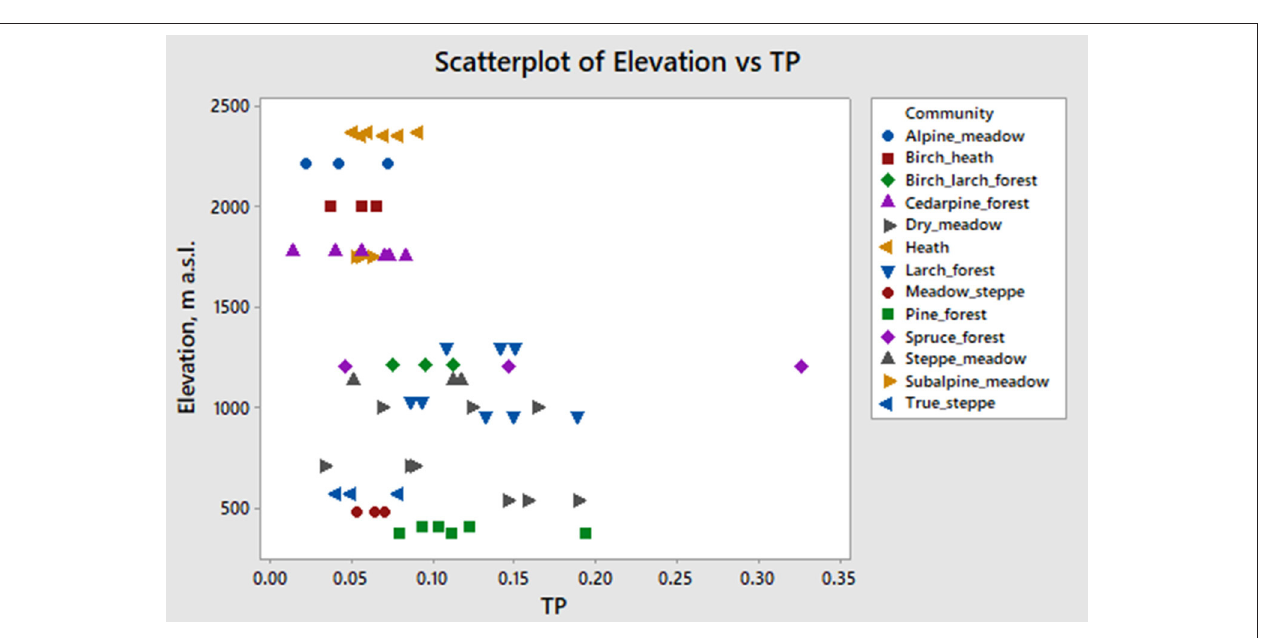
FIGURE 7 | Elevation vs. T/P index